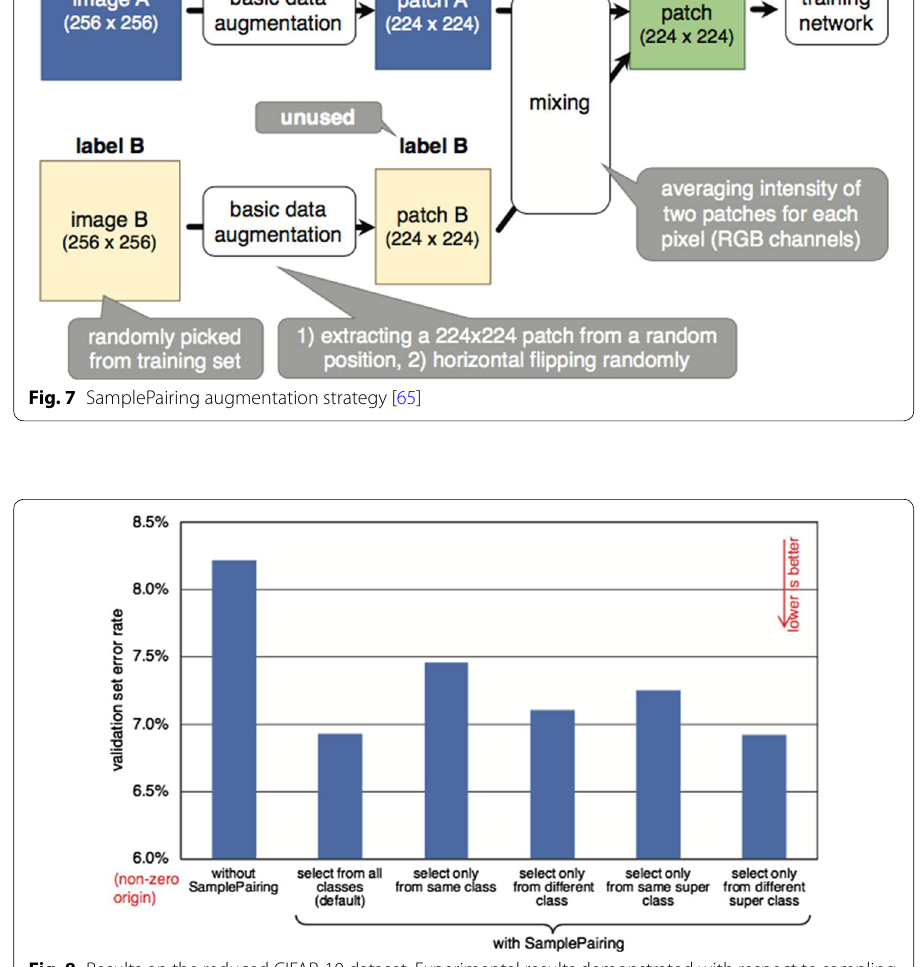
Fig. 8 Results on the reduced CIFAR-10 dataset. Experimental results demonstrated with respect to sampling pools for image mixing